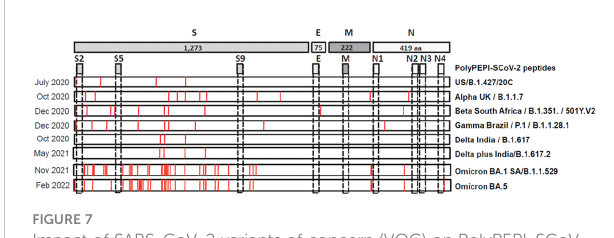
FIGURE 7 Impact of SARS-CoV-2 variants of concern (VOC) on PolyPEPI-SCoV- 2 peptides. Mutations described for major VOCs are shown and compared to PolyPEPI-SCoV-2 peptides (S2, S5, S9, E, M, N1, N2, N3 and N4)